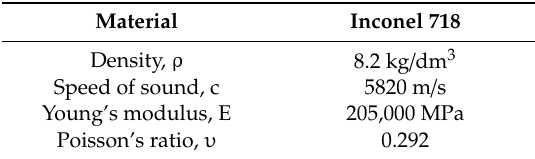
Table 2. Material properties Inconel 718. Figure 3. Quasi-one-dimensional LS-DYNA model.